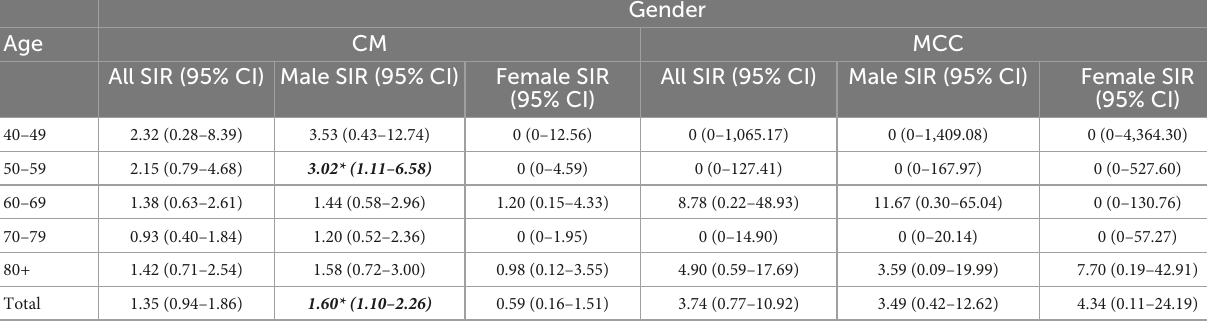
TABLE 2 Age and gender specific instances of CM and MCC.